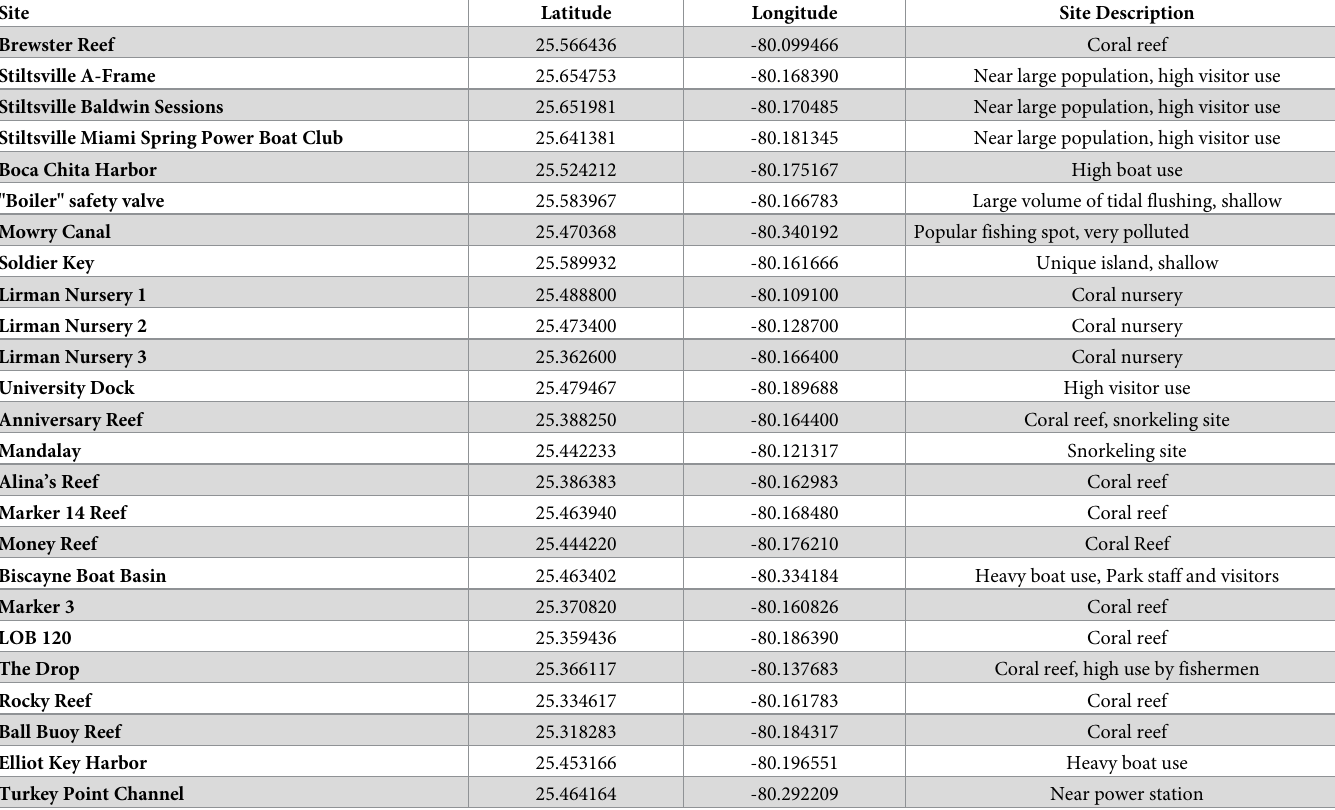
Table 1. Biscayne National Park sediment porewater sampling site names and GPS locations.